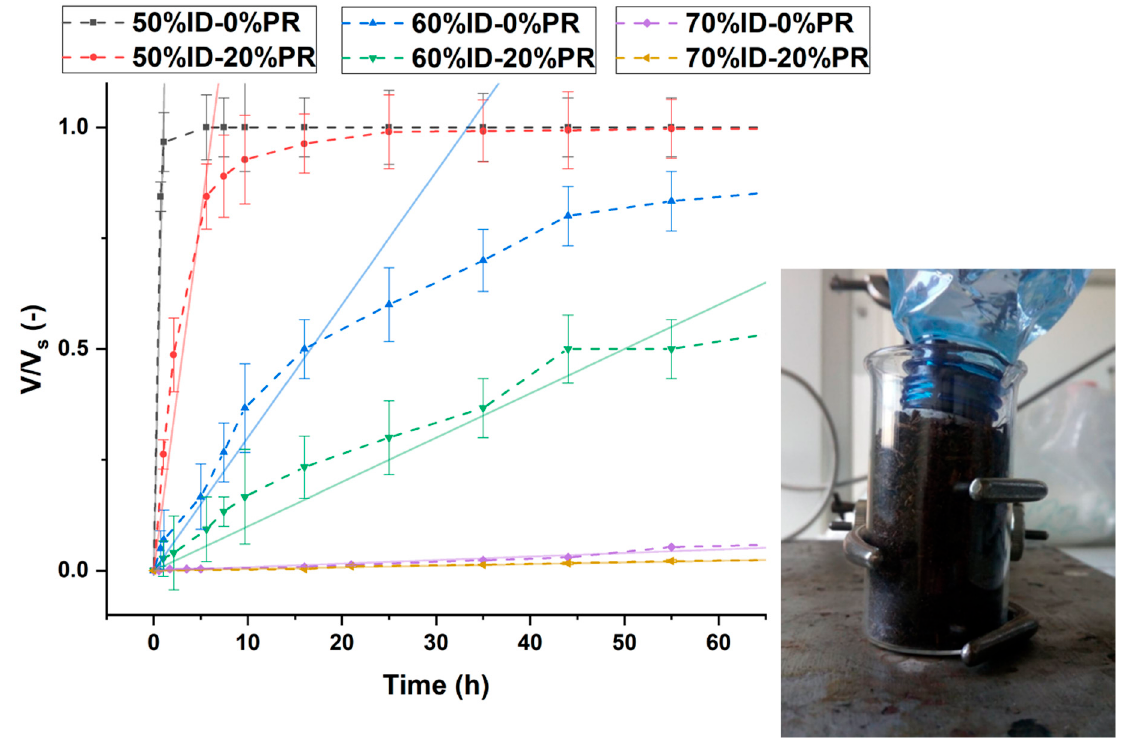
Figure 8. The volume of water absorbed and normalized on the sutured volume of the simulating soil as a function of time. The scatter curves show the data results, while the line curves show the model results.